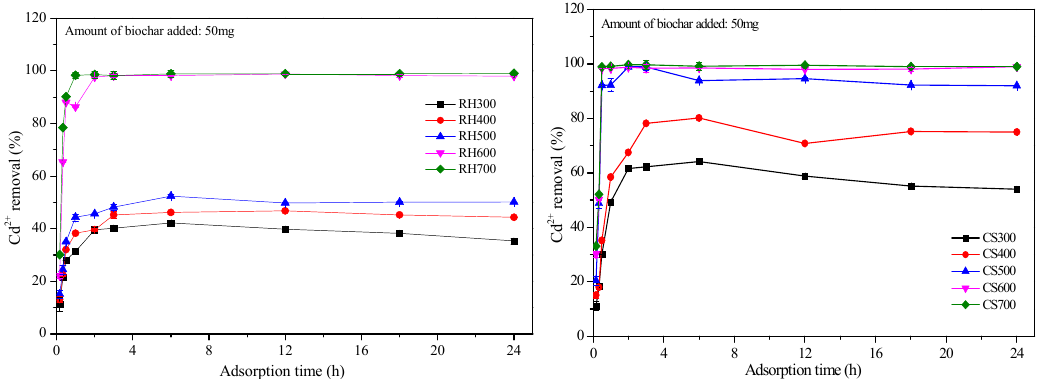
Figure 5. Effect of various adsorption times on Cd 2+ removal by both sets of biochar samples. Notes: RH300, RH400, RE500, RH600, and RH700 indicate that rice husk were pyrolyzed at 300, 400, 500, 600 and 700 °C, respectively; CS300, CS400, CS500, CS600, and CS700 indicate that cotton straw were pyrolyzed at 300, 400, 500, 600 and 700 °C, respectively.